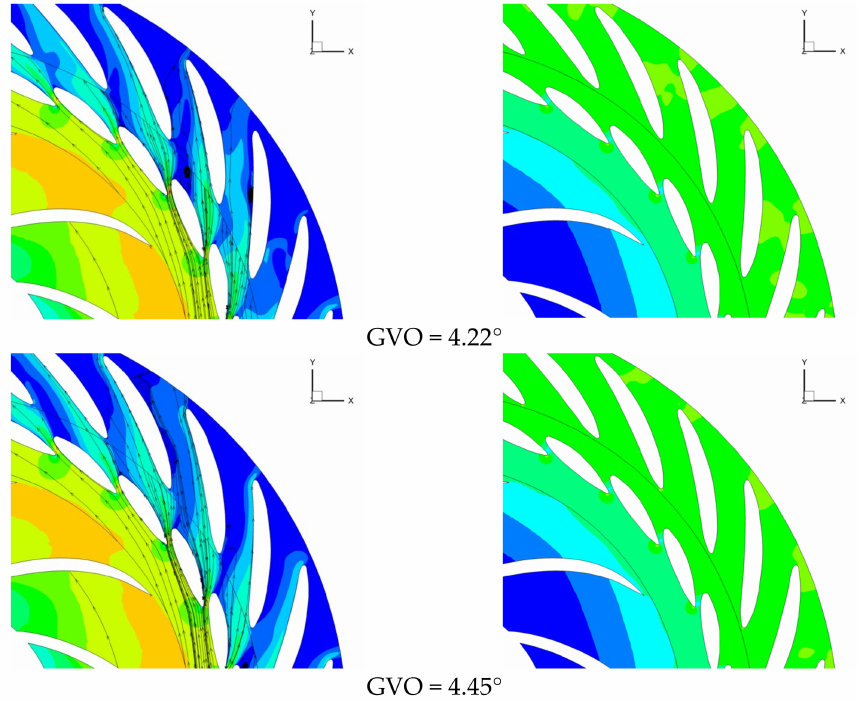
Figure 12. Local velocity contours ( left ) and pressure contours ( right ) of the startup process (Z = 0 plane).